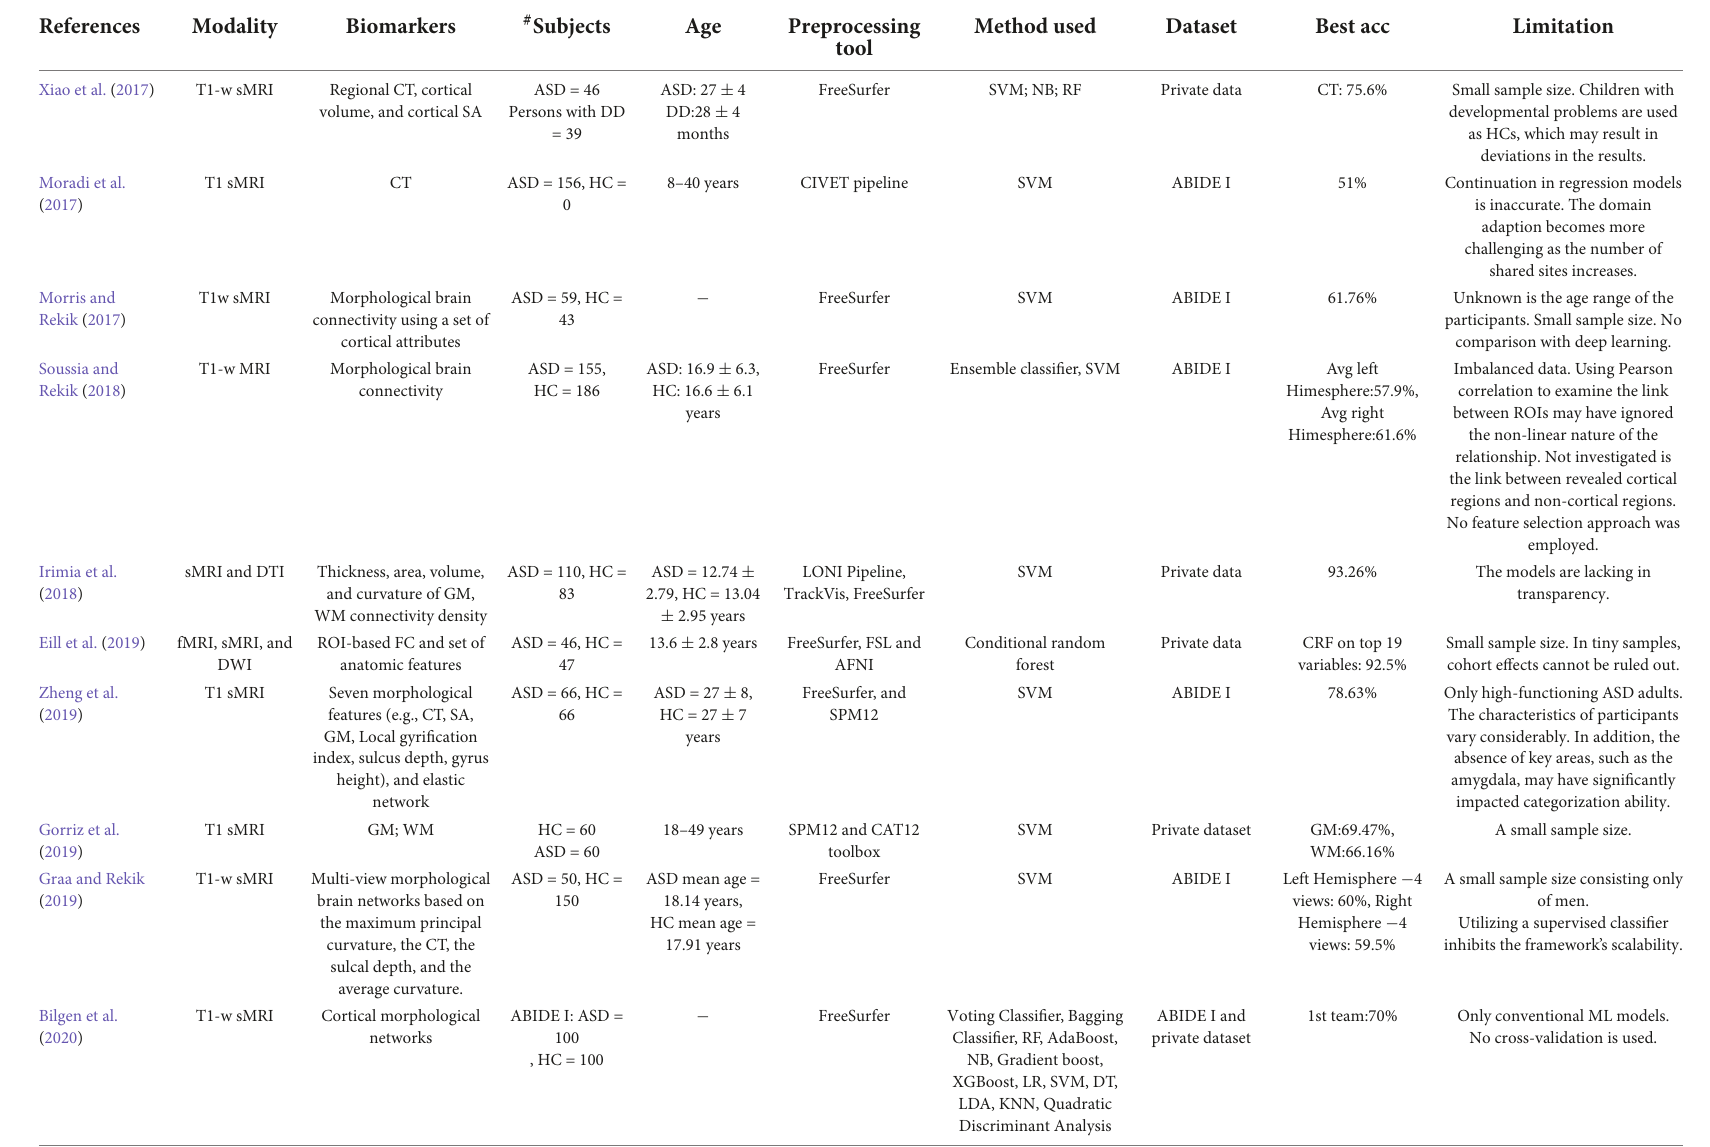
TABLE 2 Summary of 20 ML-based ASD classification